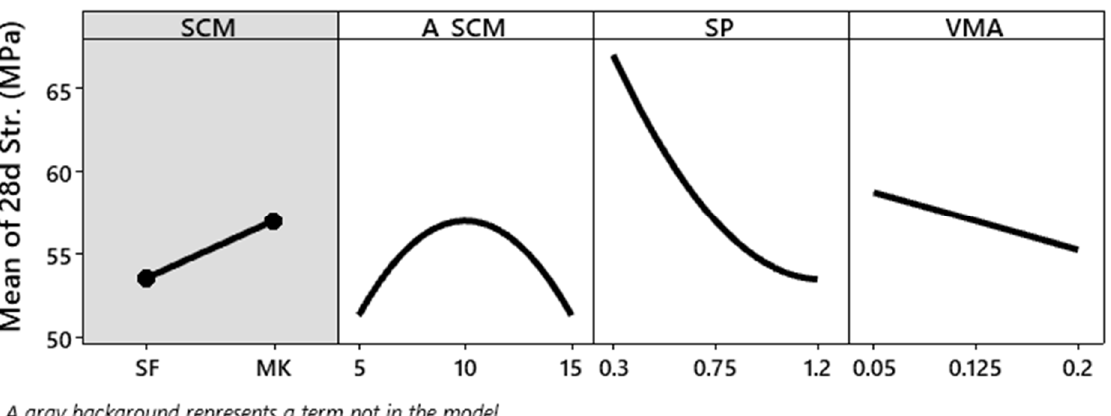
Figure 6. Main effects plot for 2-day compressive strength.